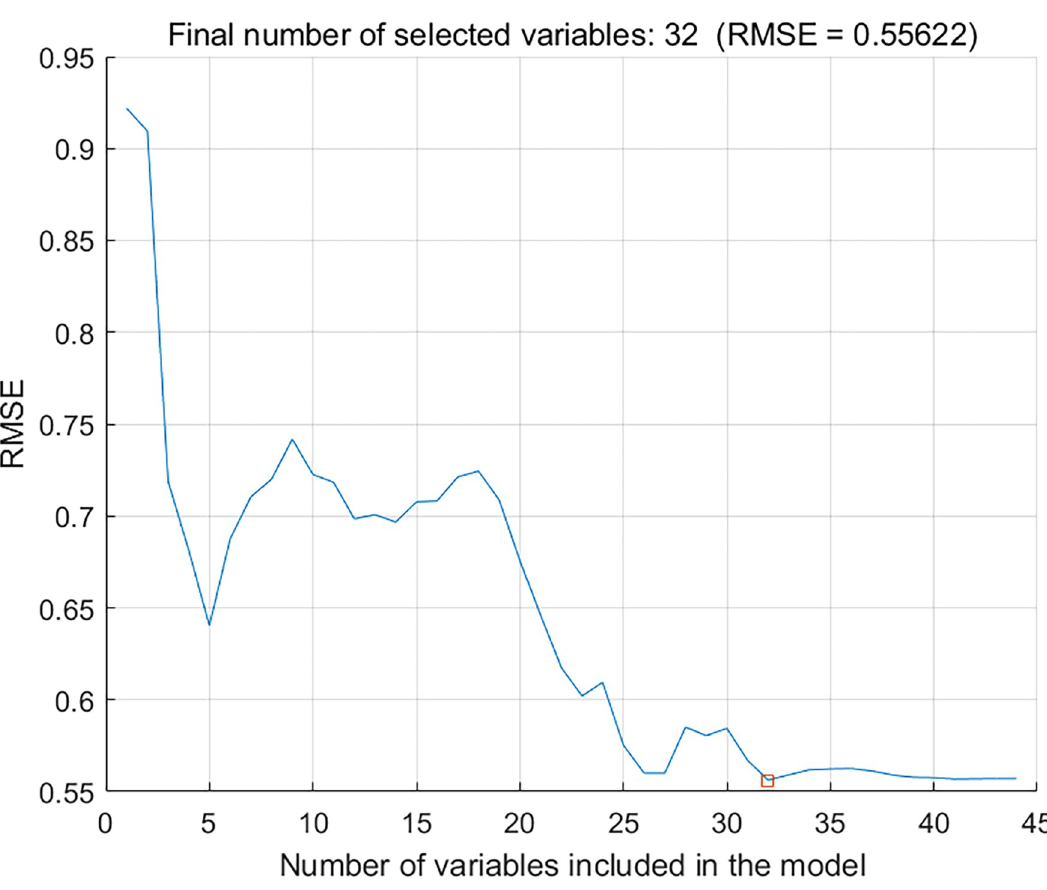
Fig 12. Number of SPA extracted characteristic wavelengths vs. RMSE